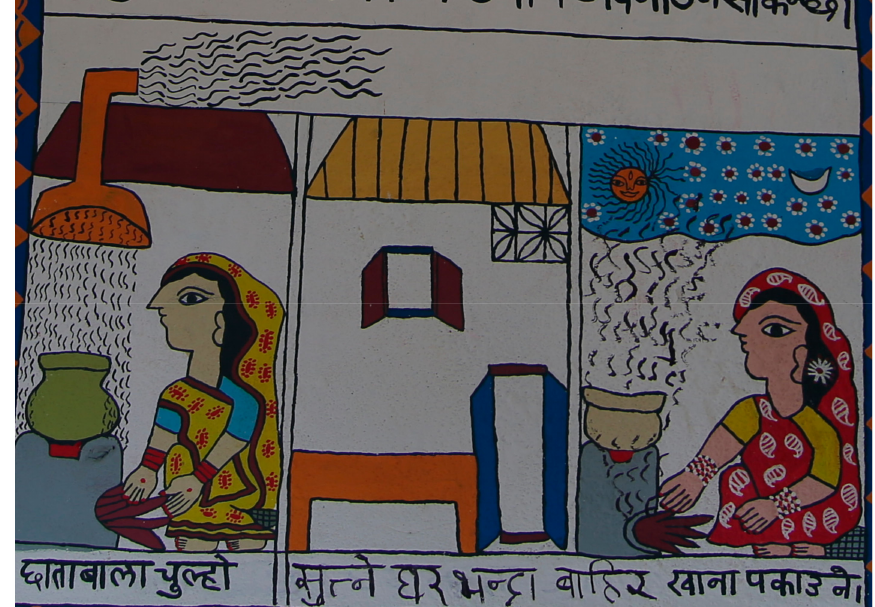
Figure 5. Potential solutions to reduce the air pollution. Translation: “Umbrella stove (hood). Cook outside the home (room) used for sleeping”. These pictures show methods to reduce air pollution exposure. On the left is a chimney or hood to channel the smoke outside. The middle picture shows increased ventilation by opening windows and doors. The right picture shows cooking